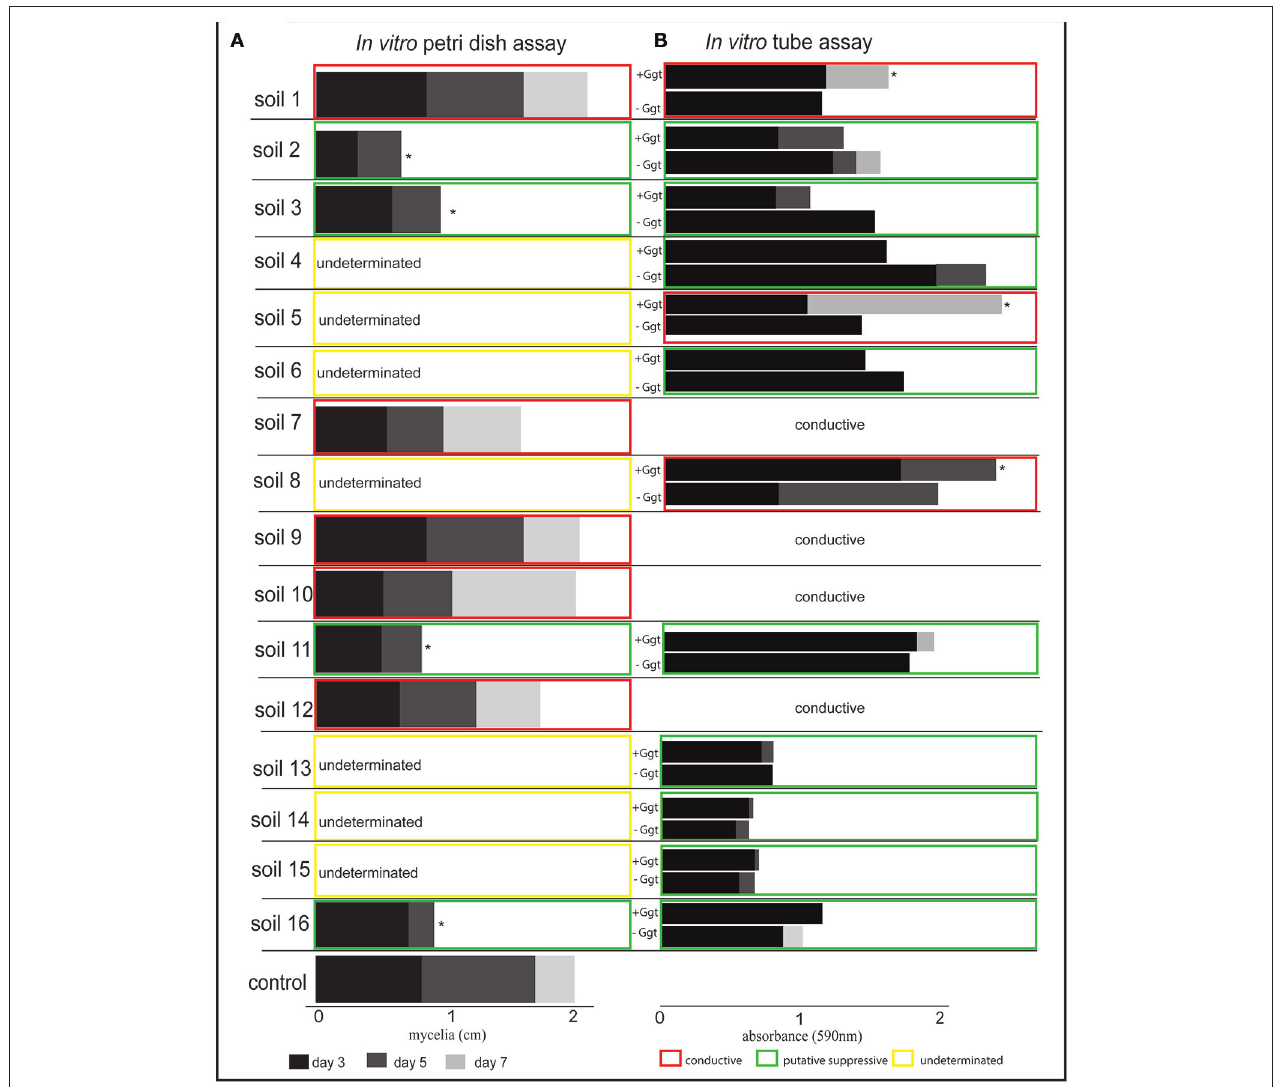
FIGURE 4 | In vitro assays to determine the inhibition of Gaeumannomyces graminis growth in the presence of rhizosphere soil samples. (A) Shows Ggt mycelial growth on solid media supplemented with the different rhizosphere soils after 3, 5, and 7 days of incubation. (B) Shows Ggt fungal biomass in liquid rhizosphere soil extracts after 3, 5, and 7 days of incubation. Asterisks indicate significant differences (Tukey’s test, p ≤ 0.05) in relation to the positive control (solid media assay) and negative control (liquid